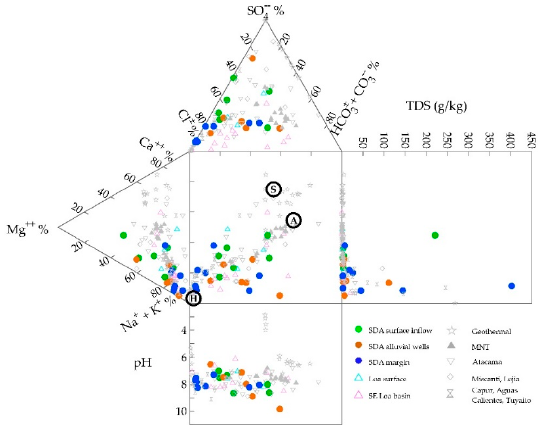
Figure 2. Durov figure including data from the Salar de Atacama (this study),the Loa groundwater basin [13], the Monturaqui-Negrillar-Tilopozo aquifer [35], neighboring basins Capur, Tuyaito and Aguas Calientes 3 [11], plus important regional thermal water